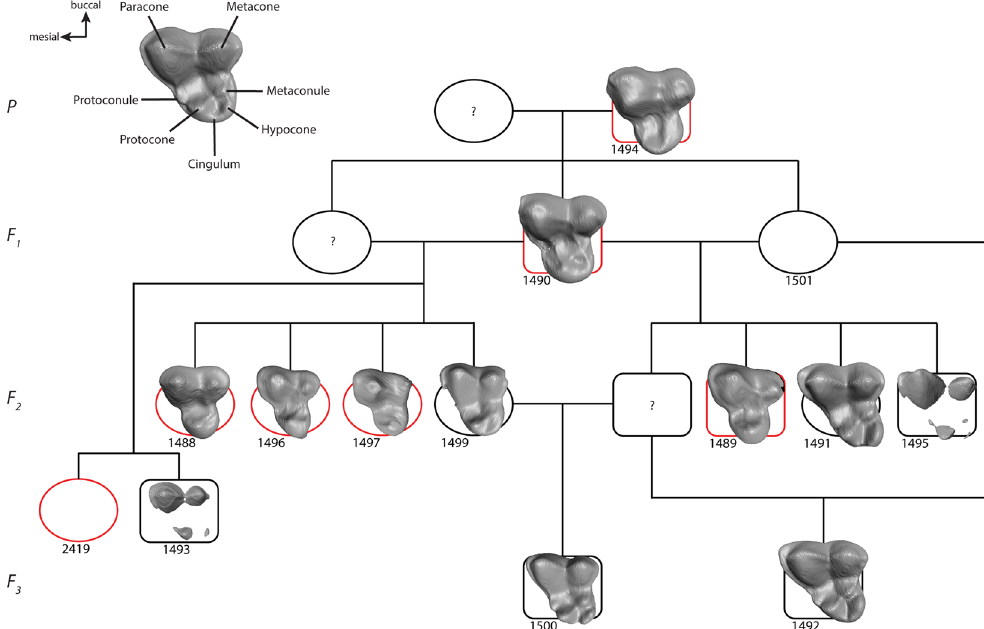
Figure 4. Upper first molar morphology mapped on genealogy of dog sample (see Fig. 2). Same symbols as in Fig. 2. The undeveloped molars of MAM 1501 and 2419 are not shown. A molar of a coated dog with normal cusp morphology is presented for comparison (top